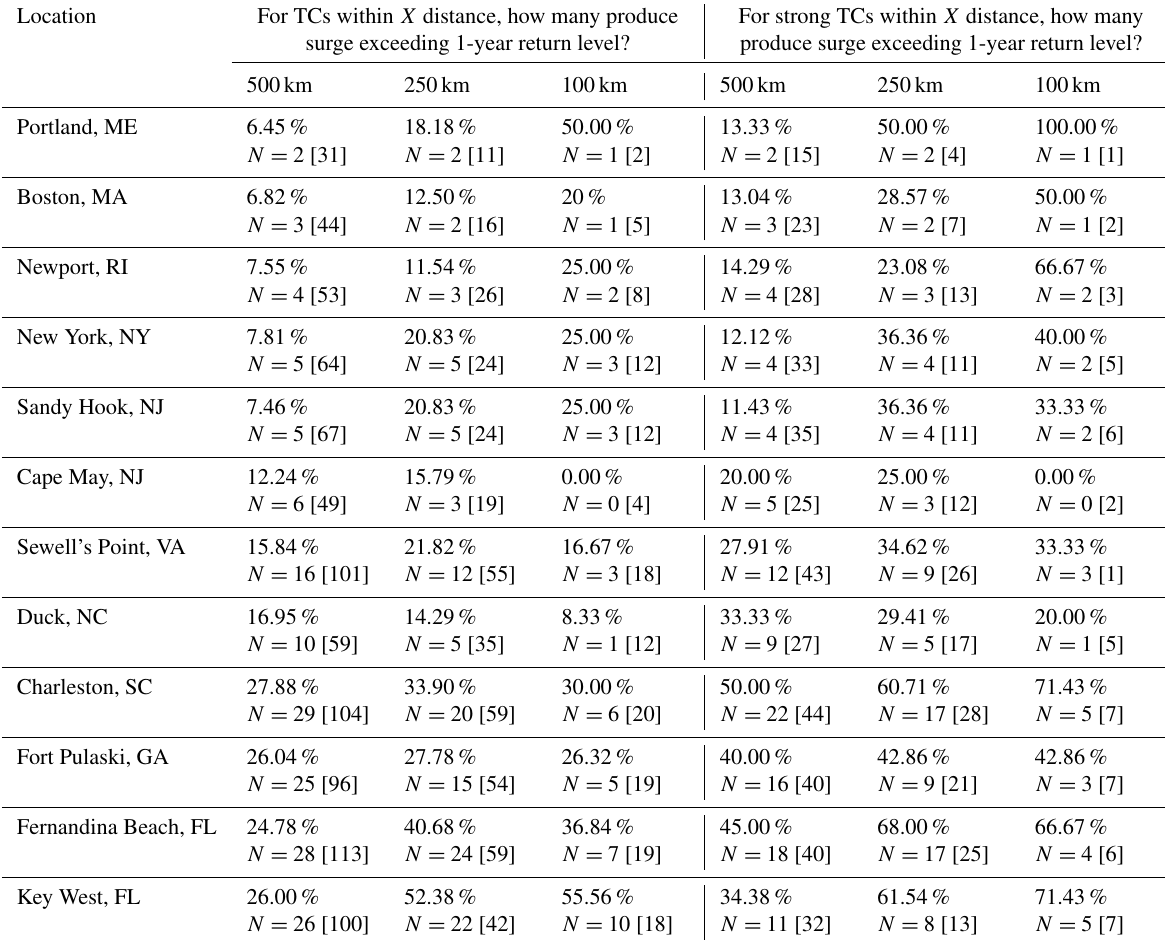
Table 4. Percentages for each location of TCs within 500, 250, and 100km under two criteria: (1) within a specified distance that produced surge exceeding the 1-year return level and (2) within a specified distance and whose MSLP is less than or equal to the average MSLP of all TCs within a specified distance that produced surge exceeding the 1-year return level. The number of individual TCs that met all criteria is given by N , and the total number of TCs that met the distance and/or intensity criteria but did not exceed the return level is given by the bracketed number. The N number divided by the bracketed number will give the percentage in the same box. Location For TCs within X distance, how many produce